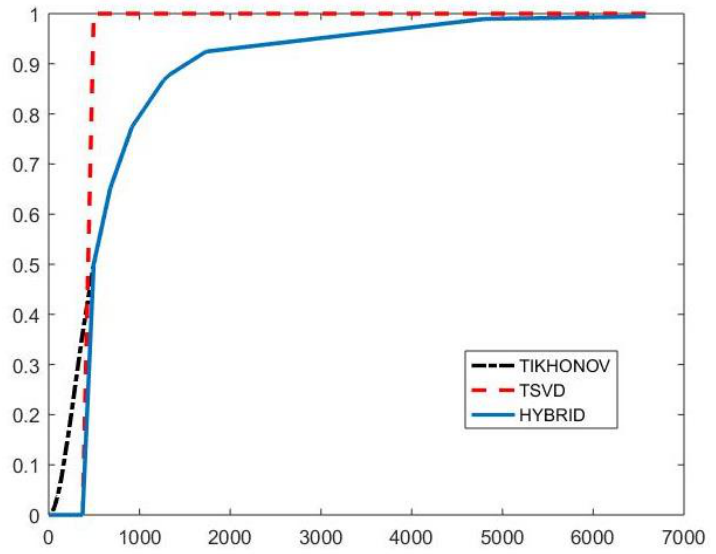
(black dashdotted line) while for smaller values